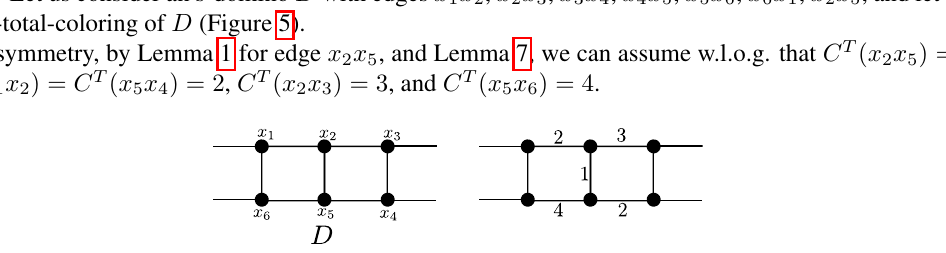
Fig. 5: Strong-edge-coloring applied to edge x 2 x 5 of D